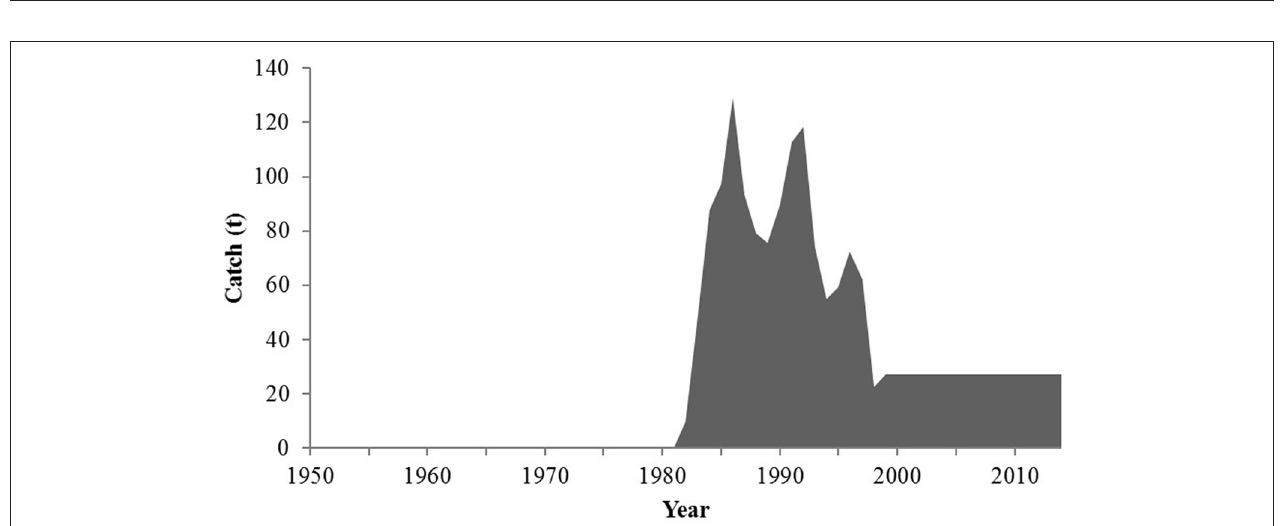
FIGURE 4 | Total reconstructed deep-bottom catches (included bycatch) in Vanuatu waters,